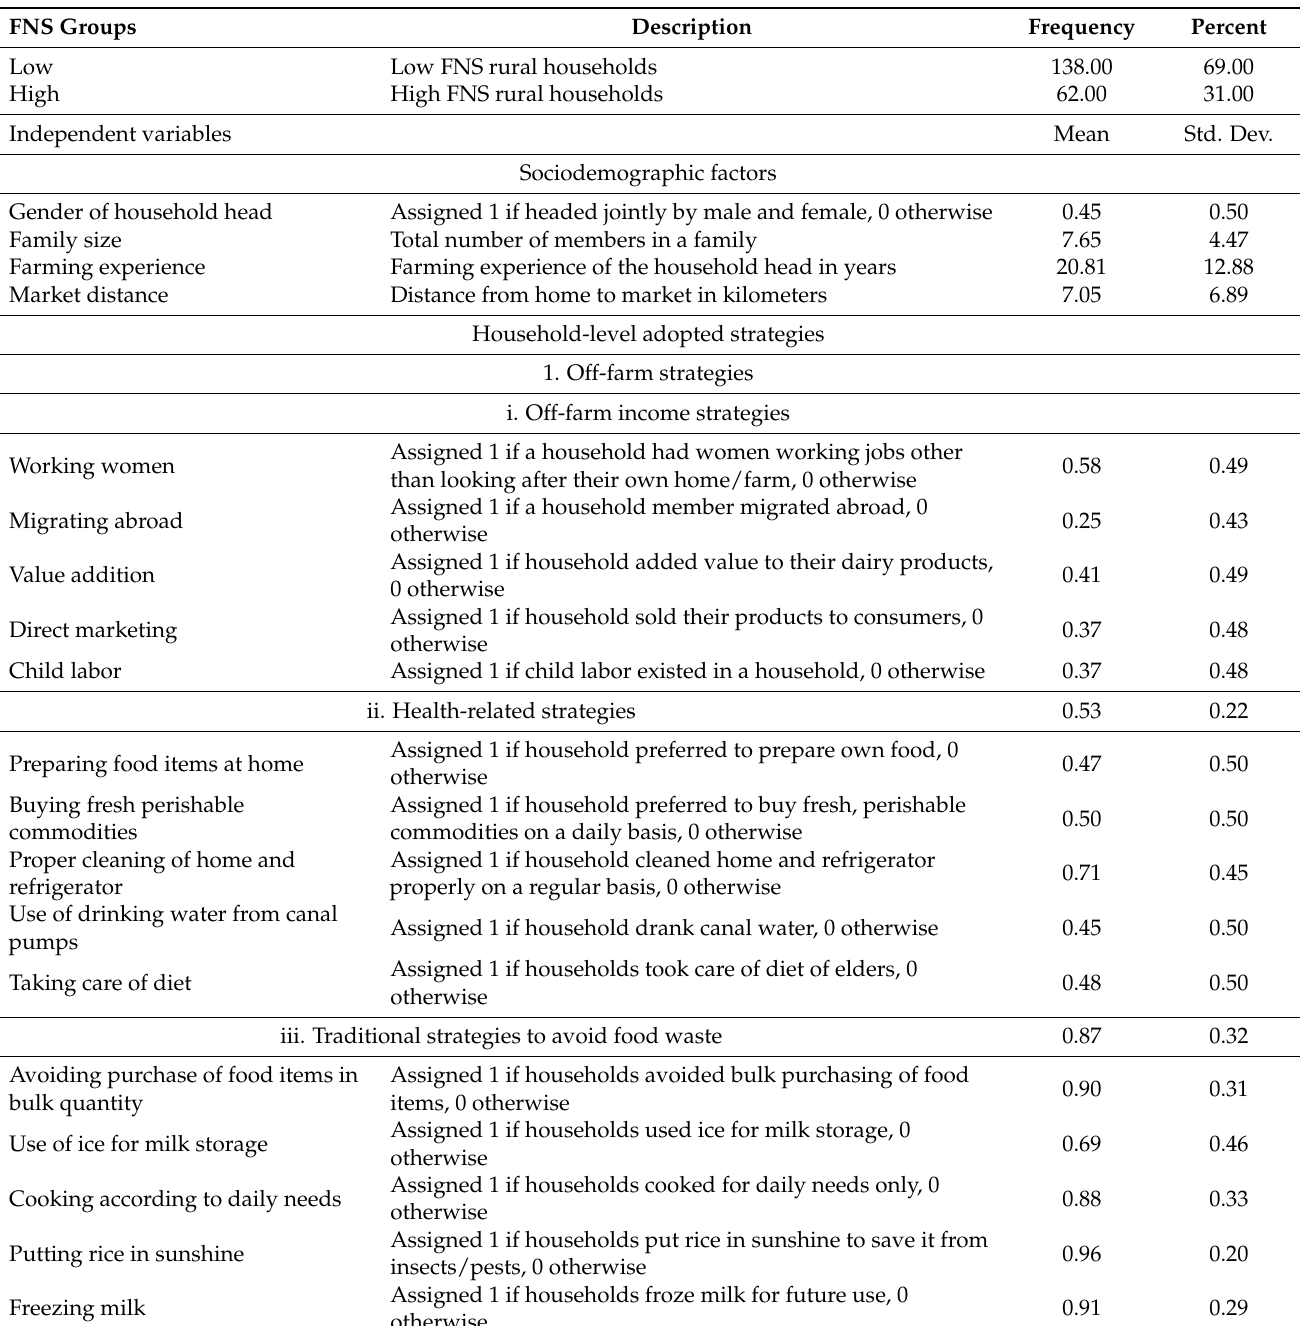
Table 2. Descriptive analysis for sampled rural